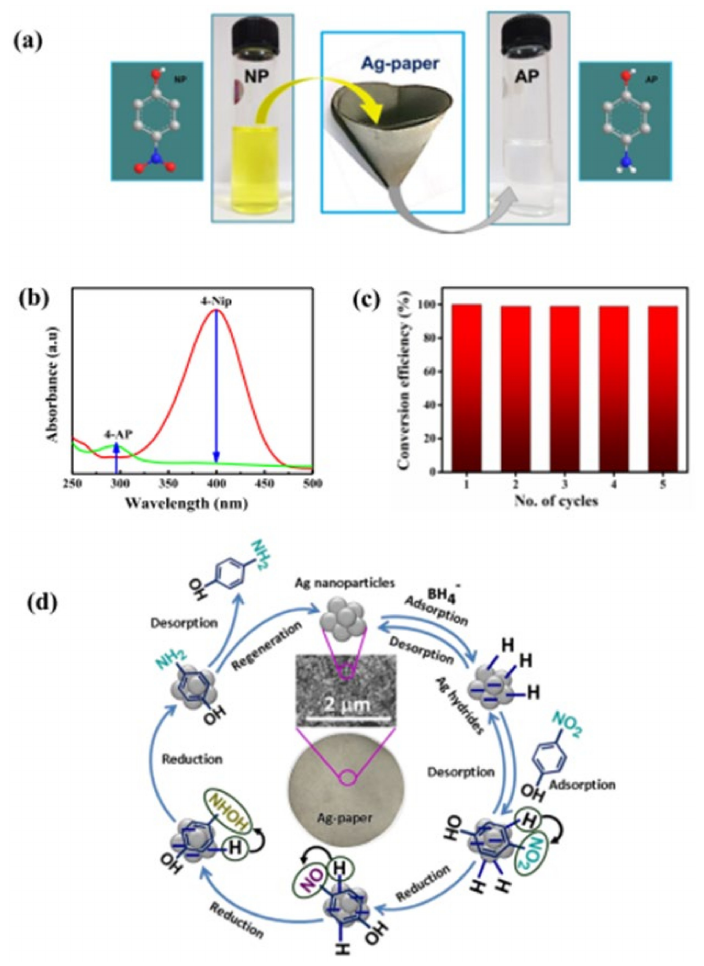
Figure 9. ( a ) schematic illustration of 4-NP reduction using Ag paper catalyst, ( b ) UV-vis absorption spectra of 4-NP before and after the Ag paper, ( c ) conversion efficiency for five repetitive cycles, and ( d ) schematic of a possible reaction